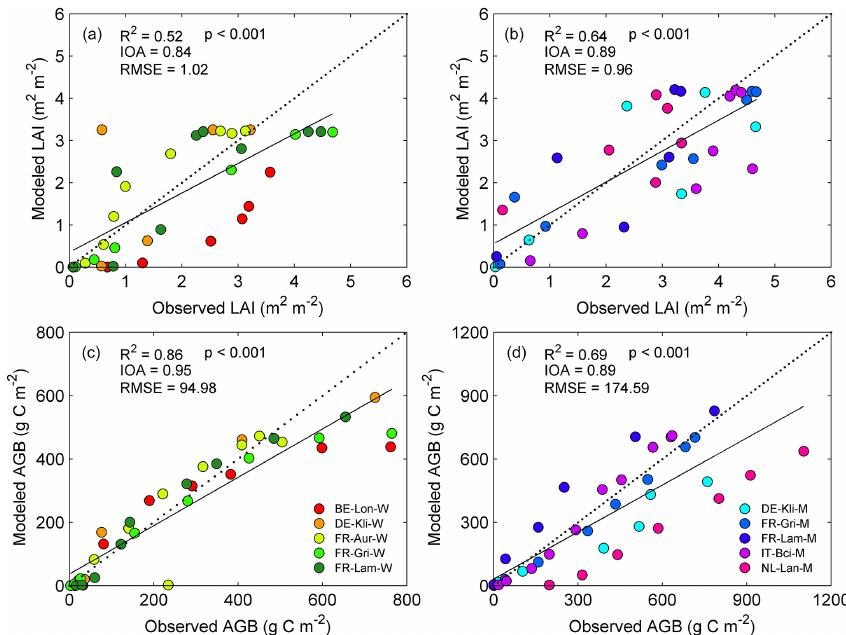
Figure 5. Scatter plots of the modeled (ORC-CP1; in detail see Table 3) and observed daily LAI and aboveground biomass (AGB) for different sites of winter wheat (a and c) and maize (b and d) , respectively. The units for RMSE of LAI and AGB are m 2 m − 2 and gCm − 2 , respectively. Different colors indicate different crop-sites with red, orange, light green, green, and dark green for winter wheat (-W) at BE-Lon, DE-Kli, FR-Aur, FR-Gri, and FR-Lam, respectively, and with light blue, medium blue, blue, purple, and violet for maize (-M) at DE-Kli, FR-Gri, FR-Lam, IT-Bci, and NL-Lan,